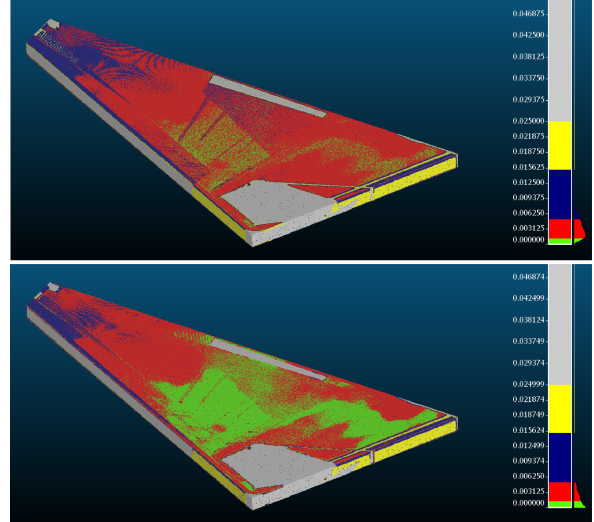
Figure 4. Results from CloudCompare (micro scale) - floor with ID 1191172 - original point cloud as reference (BIM compared to point cloud) - no local model for classification of occlusion - maximum deviation for occlusion = 25 mm Top: no local model for LOA classification Bottom: with local model for LOA classification Colors according to LOA class, grey is classified as occluded (deviations in [m])